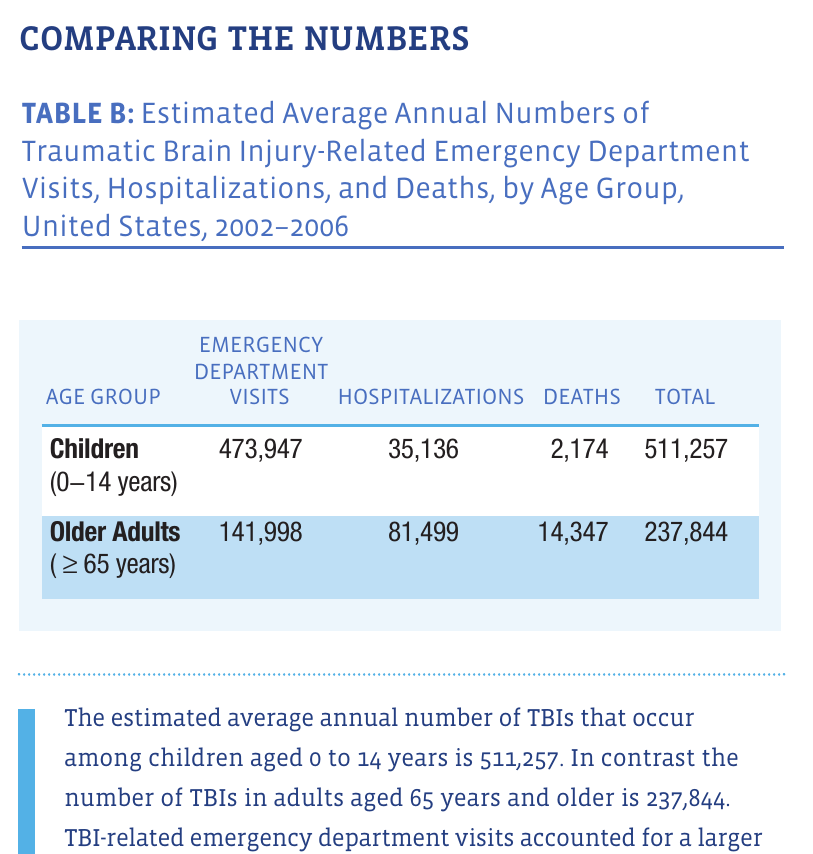
traumatic Brain Injury in the united states